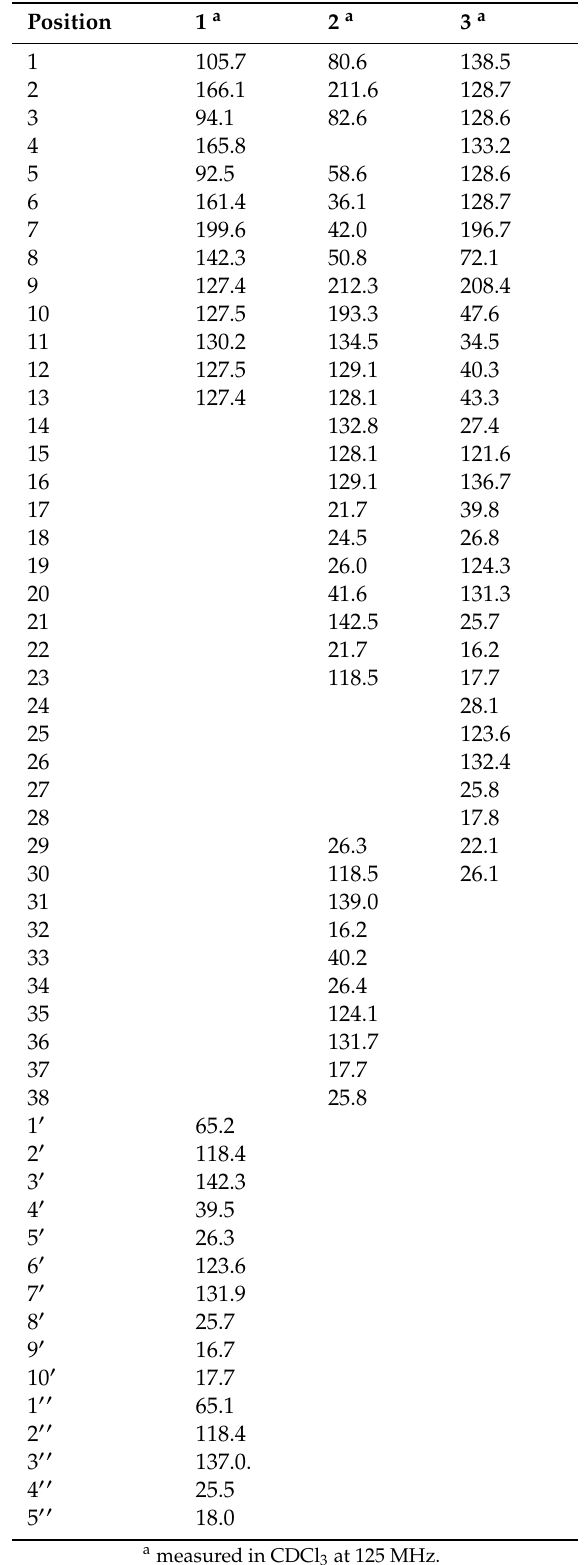
Table 3. 13 C-NMR data for Compounds 1 – 3 ( δ in